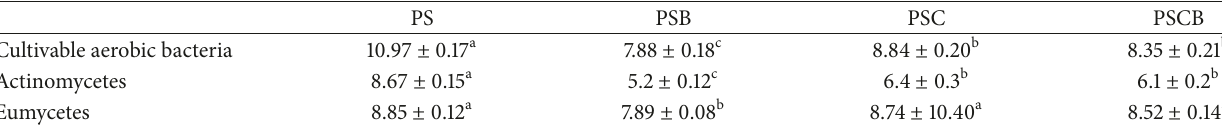
Table 3: Soil microbiological characteristics . Values are expressed as log CFU / g dry weight (DW). Data represent the mean ( 𝑛 = 3 ) ± standard error. Mean values marked with the same letter are not statistically different. One-way ANOVA was applied to weigh the effects of different treatments( 𝑝 < 0.05 ).PS=unfertilizedsoil;PSB=unfertilizedsoilplusbiochar;PSC=unfertilizedsoilpluscompost;andPSCB=unfertilized soil plus compost and biochar.